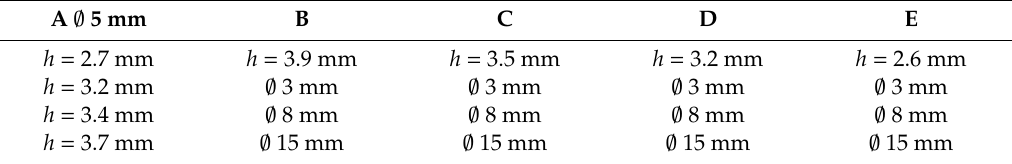
Table 1. Dimensions of defects simulated in 4.2 mm thick acrylic glass